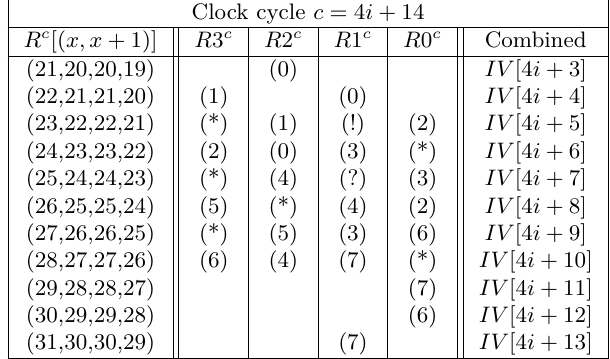
Table 7: Bit relations learnt from introducing differences at IV [4 i + j ] where j = { 0 , . . . , 7 } . The first column denotes the indices of each shift registers. ( j ) denotes where the relation is obtained, (!), (?) and (*) denote derived relation from multiple sources. The “Combined” column denotes the difference position in the IV to obtain the 4 combined bit